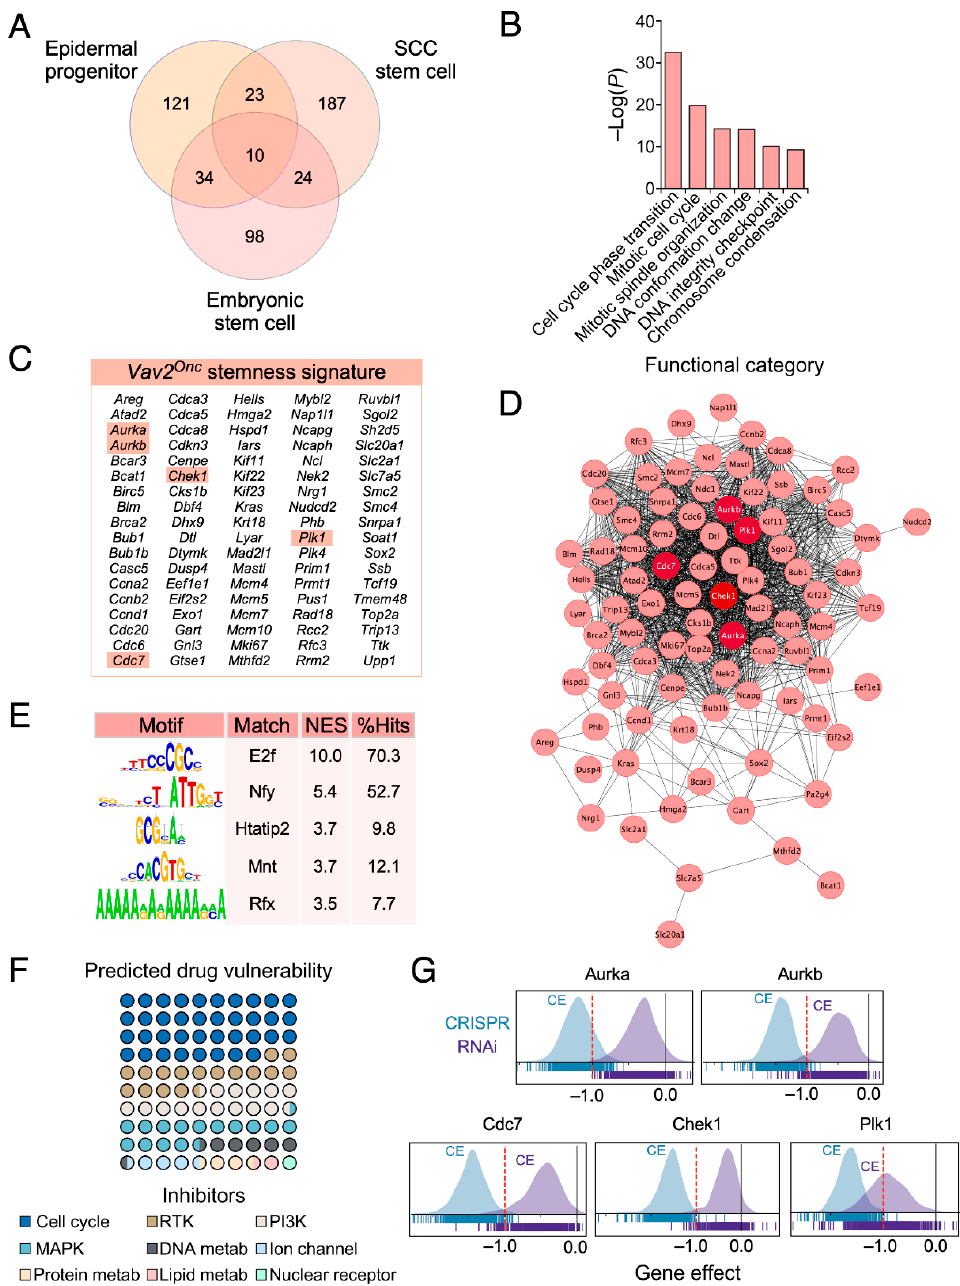
Figure 2. Identification of druggable Vav2 Onc -induced cell stemness targets. ( A ) Venn diagram showing the overlap among the different Vav2 Onc -induced stemness signatures according to the GSEA shown in Figure 1A,C,E. ( B ) Main functional categories encoded by the Vav2 Onc common SCL signature (CSS). ( C ) List of genes comprising the Vav2 Onc CSS. Those that were selected as candidate druggable targets are highlighted in color. ( D ) Protein interaction network of the genes comprising the Vav2 Onc CSS. Those that were selected as candidate druggable targets are highlighted in dark color. ( E ) Enriched transcription factor binding sites in the promoter regions of the genes belonging to the Vav2 Onc CSS. The normalized enrichment score (NES) and percentage of hits for each transcription factor binding site are also indicated. ( F ) Sector graph showing the top drug categories enriched against the Vav2 Onc CSS according to the LINCS project. The number of circles is proportional to the enrichment Z score. ( G ) DepMap analysis of the dependency of tumor cell line panels in CRISPR (blue) and RNAi (purple) databases for the indicated genes (top). Strong dependency is indicated as common essential (CE).